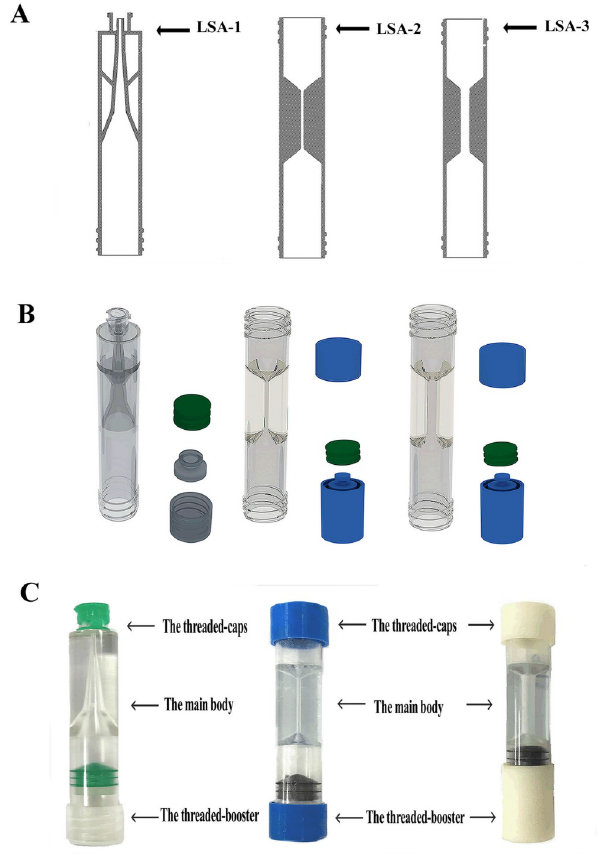
Fig 1. Schematic diagram of the leukocyte sorting accumulators. (A) Drawings of the LSAs models (from left to right: LSA-1, LSA-2 and LSA-3). (B) 3D modeling of the LSAs. (C) Photographs of the LSAs. LSA models consisting of the threaded-caps, the main body, and the